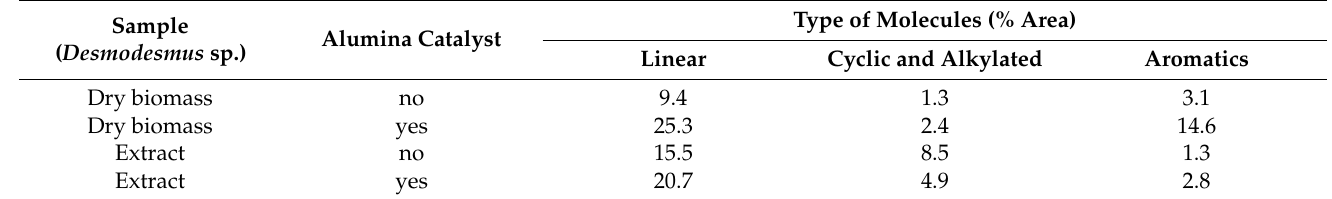
Table 3. Semiquantitative estimation of the type of molecules (linear, cyclic + alkylated, and aromatics) of the C5–C12 fraction after pyrolysis at 600 ◦ C of Desmodesmus sp. microalgae and of its n-hexane extract, in presence or absence of alumina catalyst.